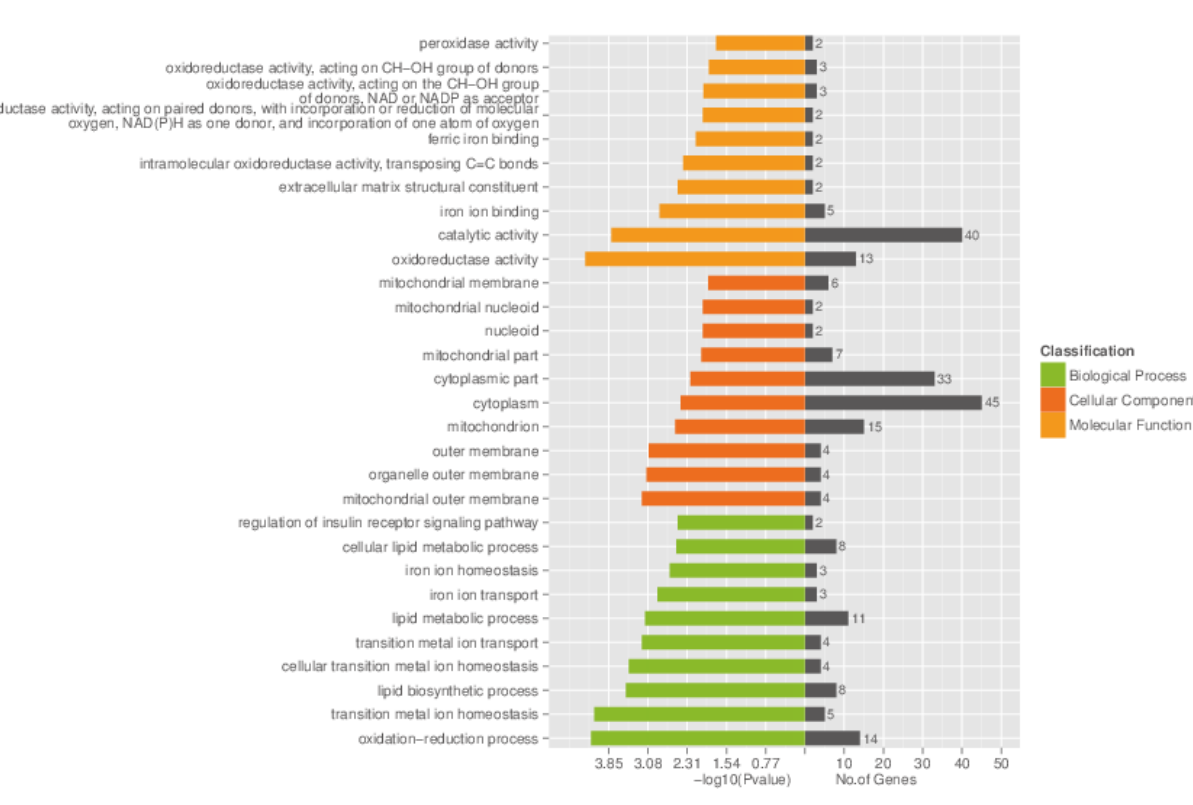
Figure 3. Heat maps of distinguishable enriched gene ontology (GO) terms of differentially expressed circular RNAs related to host genes.